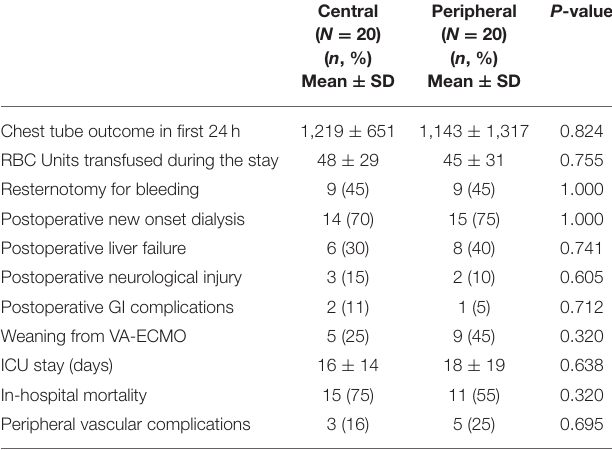
TABLE 4 | Outcome after VA-ECMO implantation after propensity score